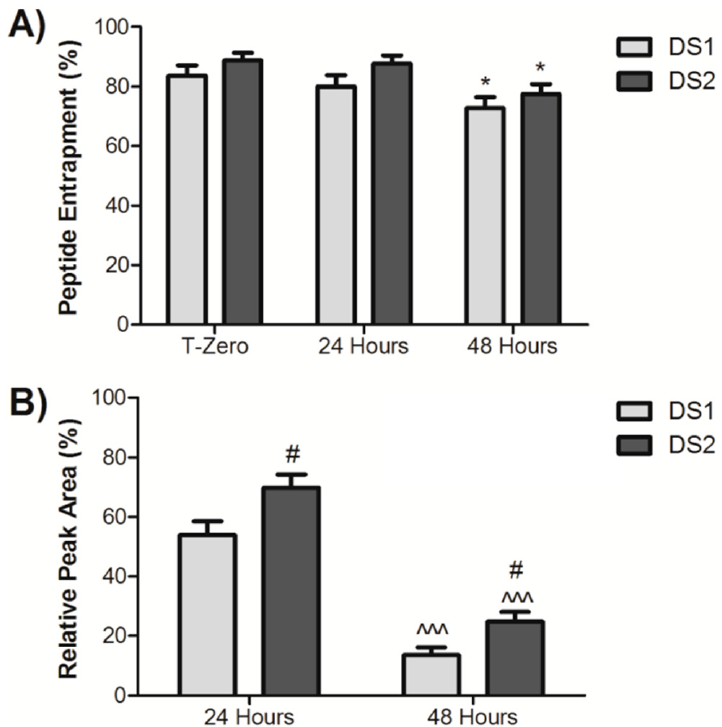
Figure 3. Glycoliposomal entrapment and plasma stability of dynantin. Dynantin was combined with DS1 or DS2 in water and the glycoliposome solutions were left at room temperature. Similar combinations of the peptide and delivery systems were incubated in human plasma at 37 ◦ C. The degree of peptide entrapment ( A ) or the levels or peptide remaining ( B ) at various time points were analyzed by RP-HPLC in the presence of 0.1% trifluoroacetic acid and detected by absorbance at 210 nm. Entrapment results are represented as the percentage of entrapped peptide relative the amount determined in control samples devoid of the delivery systems. Stability results were calculated relative to the quantities determined at time point zero. All data are shown as the average ± SEM of three separate experiments. * p < 0.05 as compared to T-zero; ˆˆˆ p < 0.001 as compared to the respective formulation at 24 h; # p < 0.05 as compared to the DS1 formulation at the respective time point.